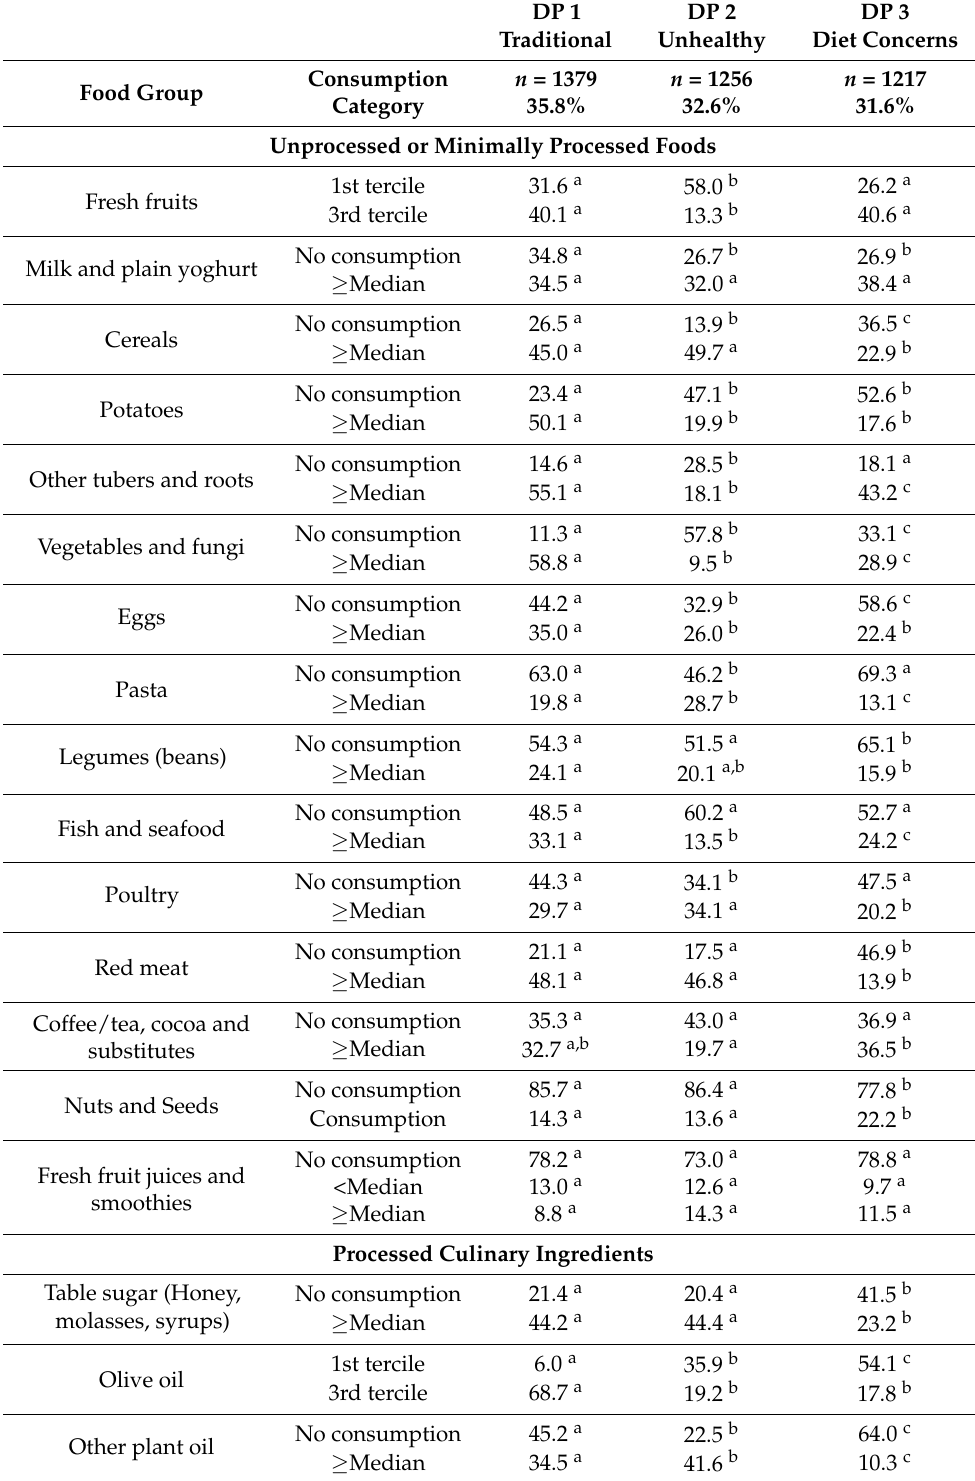
Table 1. Weighted prevalence * of subjects within consumption categories in each dietary pattern— Portuguese population aged 18–84y: The UPPER